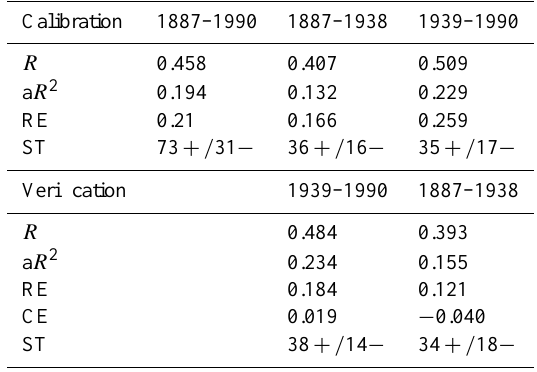
Table 2. Calibration and verification statistics for the northeast Asian March–May temperature reconstruction.